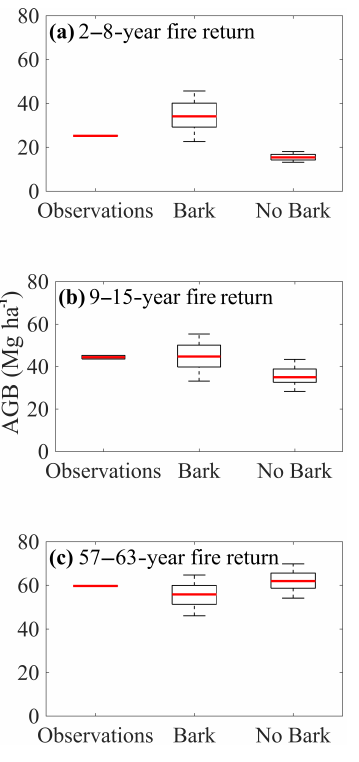
Figure 2. Tree fire survival strategy impacts aboveground tree biomass with fire disturbance. Observed and model-simulated aboveground woody biomass (AGB) under (a) high-, (b) intermediate-, and (c) low-frequency fire regimes. Model simula- tions included a 35-year model spin-up in accordance with the dis- turbance history of the observations (Pellegrini et al., 2014). Sim- ulated AGB was compared over the subsequent 10-year period for the model with bark and the model without bark. For model output, the red line denotes the predicted median AGB, the black box de- notes the interquartile range, and the dotted error bars denote ± 2 . 7 standard deviations over the subsequent 10-year period following the 35-year spin-up. For the observations, variation in AGB is due to variation in biomass across plots at the time of sampling. See Methods for additional details.